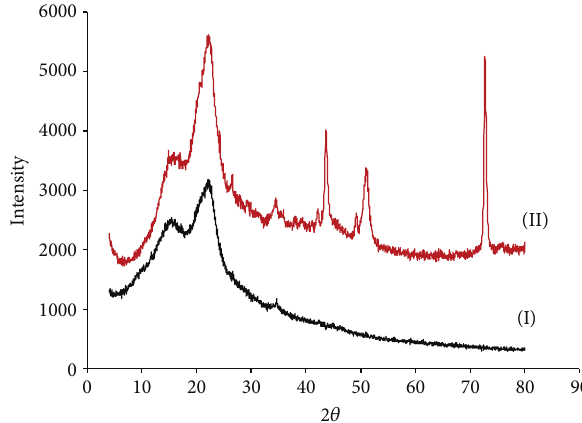
Figure 2: Typical XRD patterns of (I) raw wood and (II) WPC.